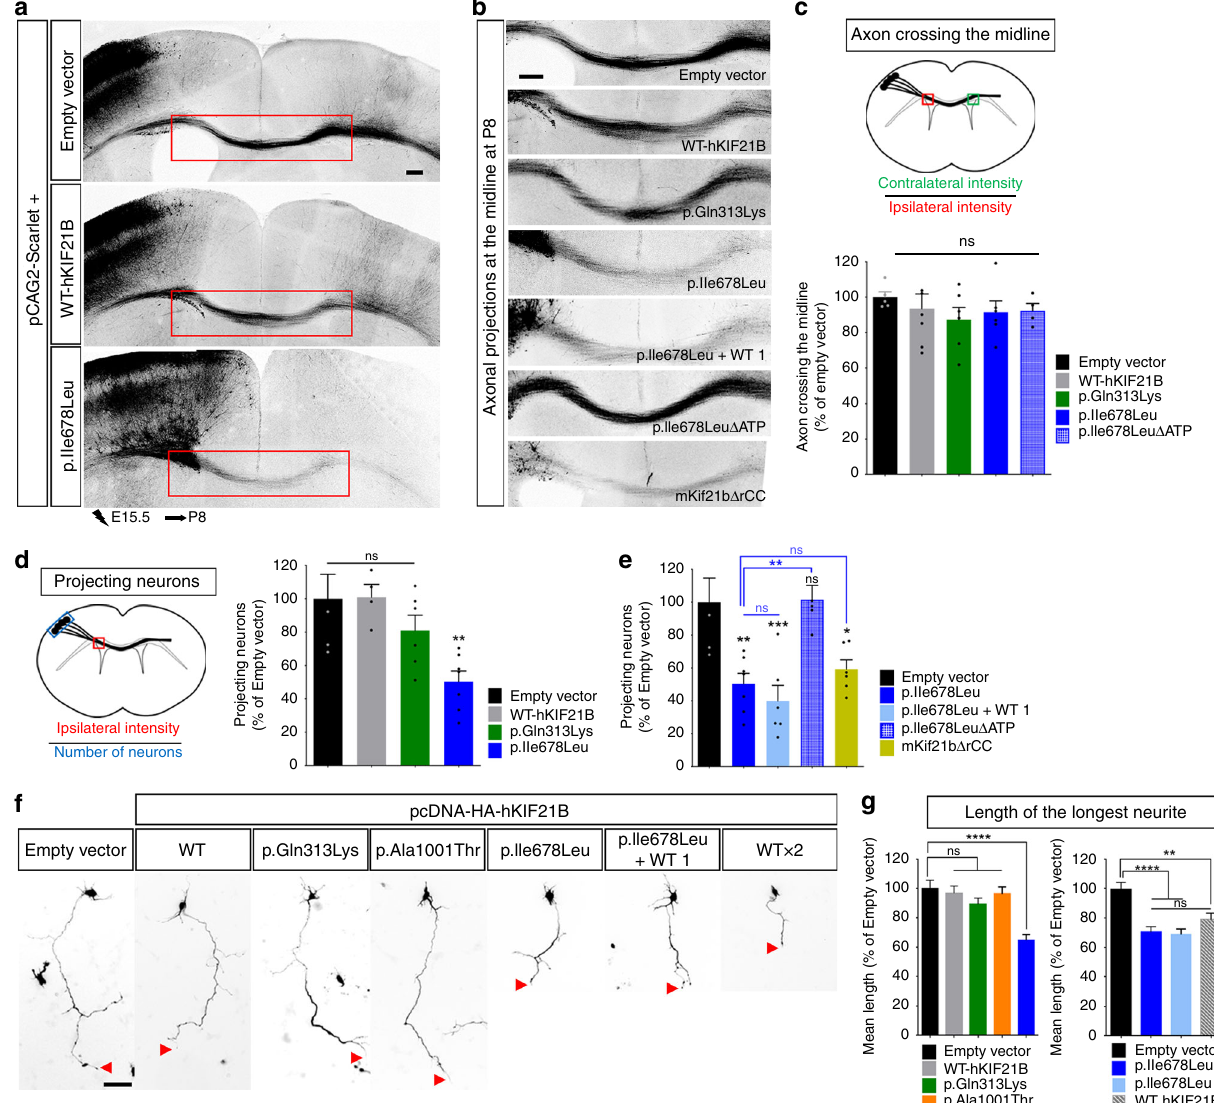
Fig. 6 p.Ile678Leu hKIF21B variant impedes inter-hemispheric connectivity. a Coronal sections of P8 brains after IUE with pCAG2-Scarlet and indicated NeuroD-IRES-GFP constructs. b Close-up views of the red boxed area in a showing impaired axonal inter-hemispheric connectivity upon expression of the p. Ile678Leu variant or the hyperactive mKif21b Δ rCC but not upon expression of WT, p.Gln313Lys or immotile p.Ile678Leu Δ ATP. Rescue experiments were done by co-expressing p.Ile678Leu-hKIF21B (1 µ g/ µ L) together with WT-hKIF21B constructs at 1 µ g/ µ L (p.Ile678Leu + WT 1). Scale bars, 250 μ m. c , d Upper ( c ) or left ( d ) panels, schematic describing methods used to quantify the percentage ( c ) of axon crossing the midline and ( d ) of projecting neurons. Lower ( c ) or right ( d ) panels, histograms presenting the percentage ( c ) of axon crossing the midline and ( d , e ) of projecting neurons. Data (means± S.E.M.) were analyzed by one-way ANOVA (Bonferroni ’ s multiple comparisons test). Number of pups analyzed: c Empty vector, n = 5; WT, n = 7; p.Gln313Lys, n = 6; p.Ile678Leu, n = 6; p.Ile678Leu Δ ATP, n = 4; d , e empty vector, n = 5; WT, n = 4; p.Gln313Lys, n = 6; p.Ile678Leu, n = 7; p.Ile678Leu Δ ATP, n = 5; p. Ile678Leu + WT, n = 6; mKif21b Δ rCC, n = 6. f Representative DIV2 cortical neurons transfected at DIV0 with pCAG2-Scarlet together with empty pcDNA- HA or WT (at 1 (WT) or 2 µ g/ µ L (WT ×2)) or mutant pcDNA-HA-hKIF21B constructs. Rescue experiments were done by co-expressing mutated p. Ile678Leu hKIF21B variant together with NeuroD-WT-hKIF21B (ratio 1:1; p.Ile678Leu + WT 1). Red arrowheads point to the axon tip. g Quanti fi cation of the longest neurite length (axon) at DIV2. Bars represent the means of the longest neurite length ± S.E.M. Signi fi cance was calculated by one-way ANOVA (Bonferroni ’ s multiple comparisons test). Number of neurons analyzed: (left graph) Empty vector, n = 94; WT, n = 96; p.Gln313Lys, n = 104; p.Ile678Leu, n = 144; p.Ala1001Thr, n = 133, from four (Empty vector, WT, p.Ile678Leu) or three (p.Gln313Lys, p.Ala1001Thr) independent experiments; (right graph) empty vector, n = 132; WT 2 µ g/ µ L, n = 125; p.Ile678Leu + WT, n = 146; p.Ile678Leu, n = 134; from four independent experiments. ns non-signi fi cant; * P < 0.05; ** P < 0.005; *** P < 0.001; **** P <0.0001. Scale bars, ( a ) 200 µ m, ( b ) 250 µ m ( f ) 50 µ m. Source data are provided in the Source Data fi